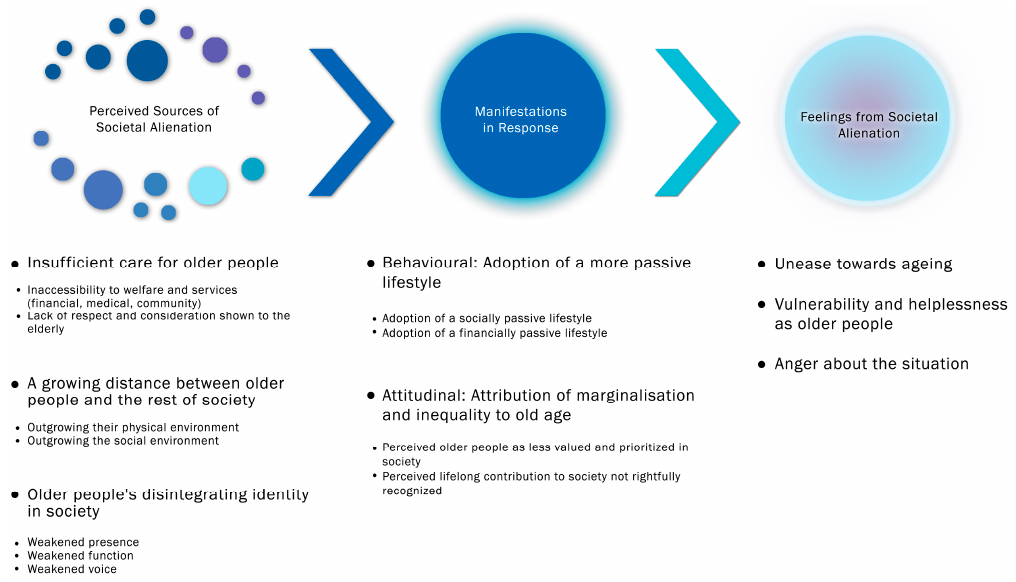
Figure 1. Key components and subthemes of older people’s experience of societal alienation.